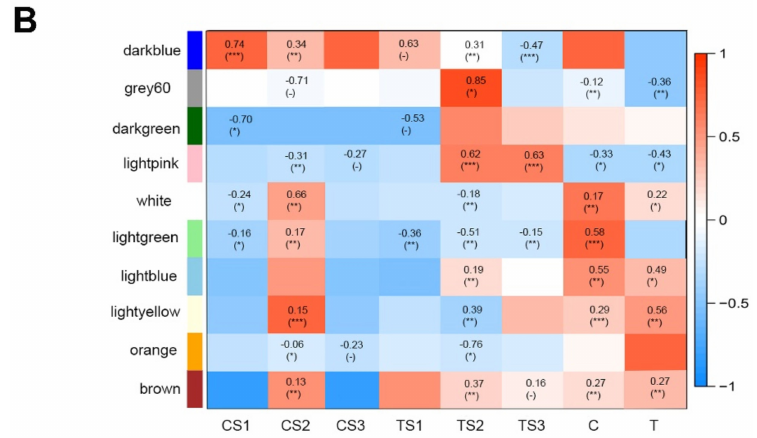
Figure 7. Gene co-expression modules discovered by WGCNA. ( A ) Clustering dendrogram of genes. Gene clustering tree (dendrogram) obtained by hierarchical clustering of adjacency-based dissimilarity. The coloured row below the dendrogram indicates the module membership determined with the dynamic tree cut method, along with the assigned colours of the merged modules and the colours of the original modules. ( B ) Module-trait associations using WGCNA. Factors of interest (x-axis) were correlated with each module (y-axis). The first value in each square is the correlation and the second value in parentheses is the p -value of the association. The more positively correlated the module and factor, the redder the square; the more negatively correlated, the bluer. The coding of the factors was as follows: CS1, CS2, CS3, TS1, TS2, TS3, C, and T. * Significant at p < 0.05; **